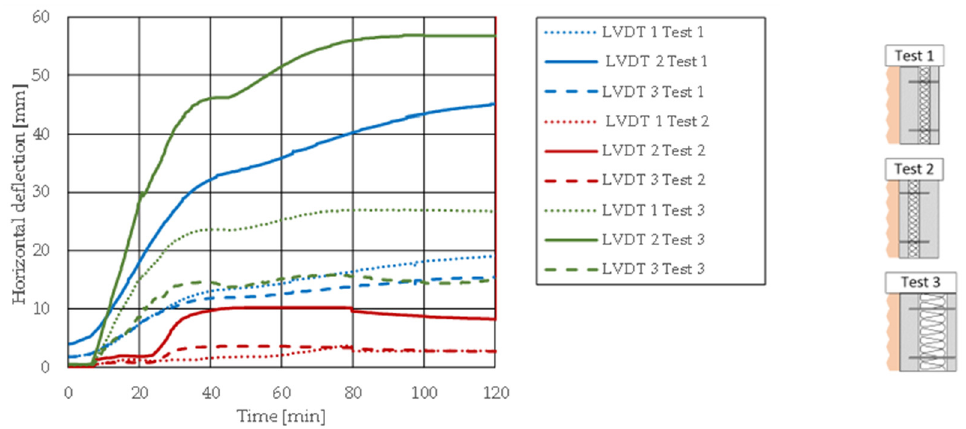
Figure 7. Horizontal deformations.